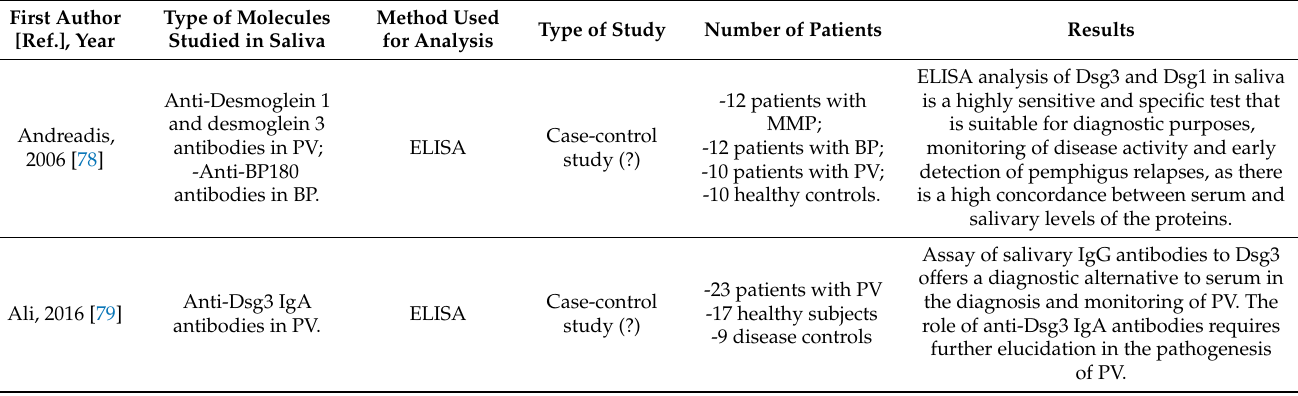
Table 2. Summary of the studies performed on the saliva of patients with blistering